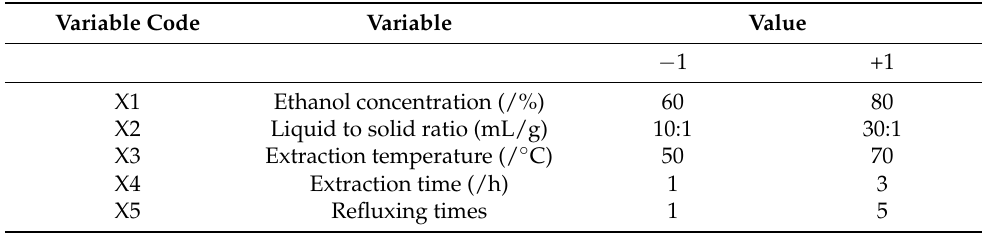
Table 1. The coded values and corresponding actual values of the extraction parameters used in Plackett–Burman design (Ethanol solution).